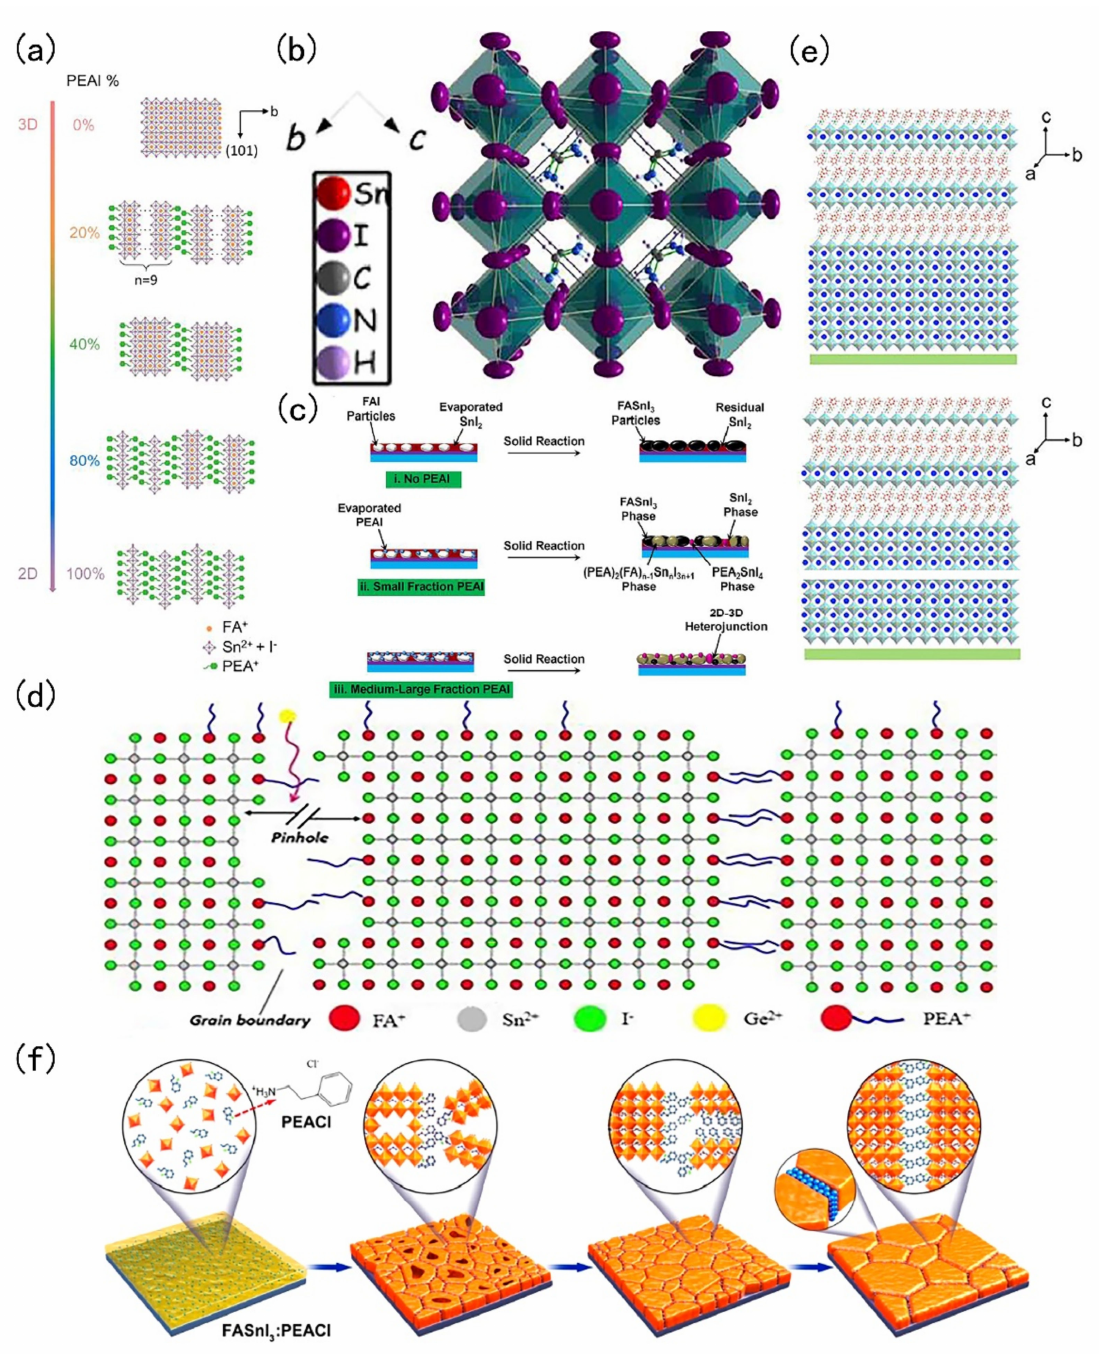
Figure 3. ( a ) As the concentration of PEAI increases, the dimension changes; Letter n denotes the average layers of tin iodide octahedra in nanolayers. Reproduced with permission from [54]. Copyright 2018 American Chemical Society. ( b ) Unit cell and crystal structure of FASnI 3 perovskite absorber. Reproduced with permission from [55]. Copyright 2017 The Authors, some rights reserved, exclusive licensee American Association for the Advancement of Science. ( c ) 2D-3D heterojunction production flow chart. Reproduced with permission from [56]. ( d ) Copyright 2018 American Chemical Society. The passivation effect of Ge within the perovskite lattice. Reproduced with permission from [57]. Copyright 2020 The Royal Society of Chemistry. ( e ) Structure characterization of the control film (up) and structure characterization of film with HSP (2D-quasi-2D-3D structure) (down). Reproduced with permission from [58]. Copyright 2018 Elsevier Inc. ( f ) Vertical orientation 2D perovskite structure was attained as the annealing temperature increases. Reproduced with permission from [59]. Copyright 2020 American Chemical